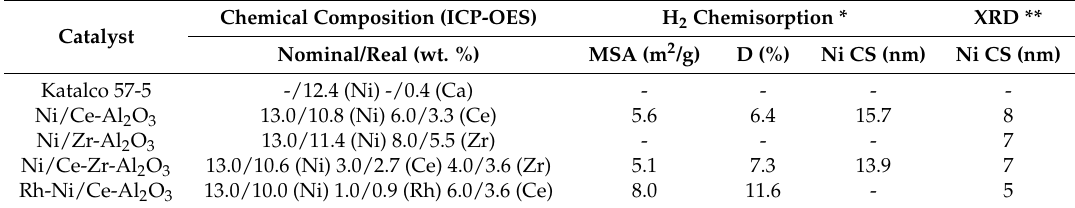
Table 2. Calcined catalysts chemical composition by ICP-OES (column 2); reduced catalysts metal surface area (MSA), dispersion (D) and Ni crystallite size (CS) by hydrogen chemisorption (column 3); and calcined catalysts Ni average CS by XRD (column